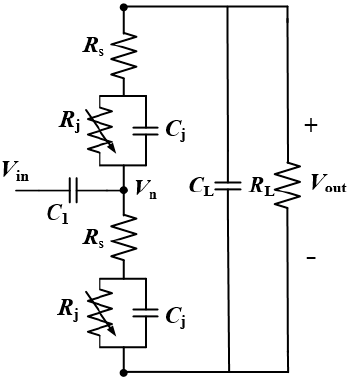
Figure 1. Equivalent circuit model of the voltage doubler diode. The time-domain waveform of PW with a repetition period of T a is shown in Figure 2. The CW power is concentrated in a partial duration of ∆ T . The ratio of ∆ T to T a is defined as the duty cycle α . The pulse time ∆ T contains M consecutive sine periods ( M = 3 in Figure